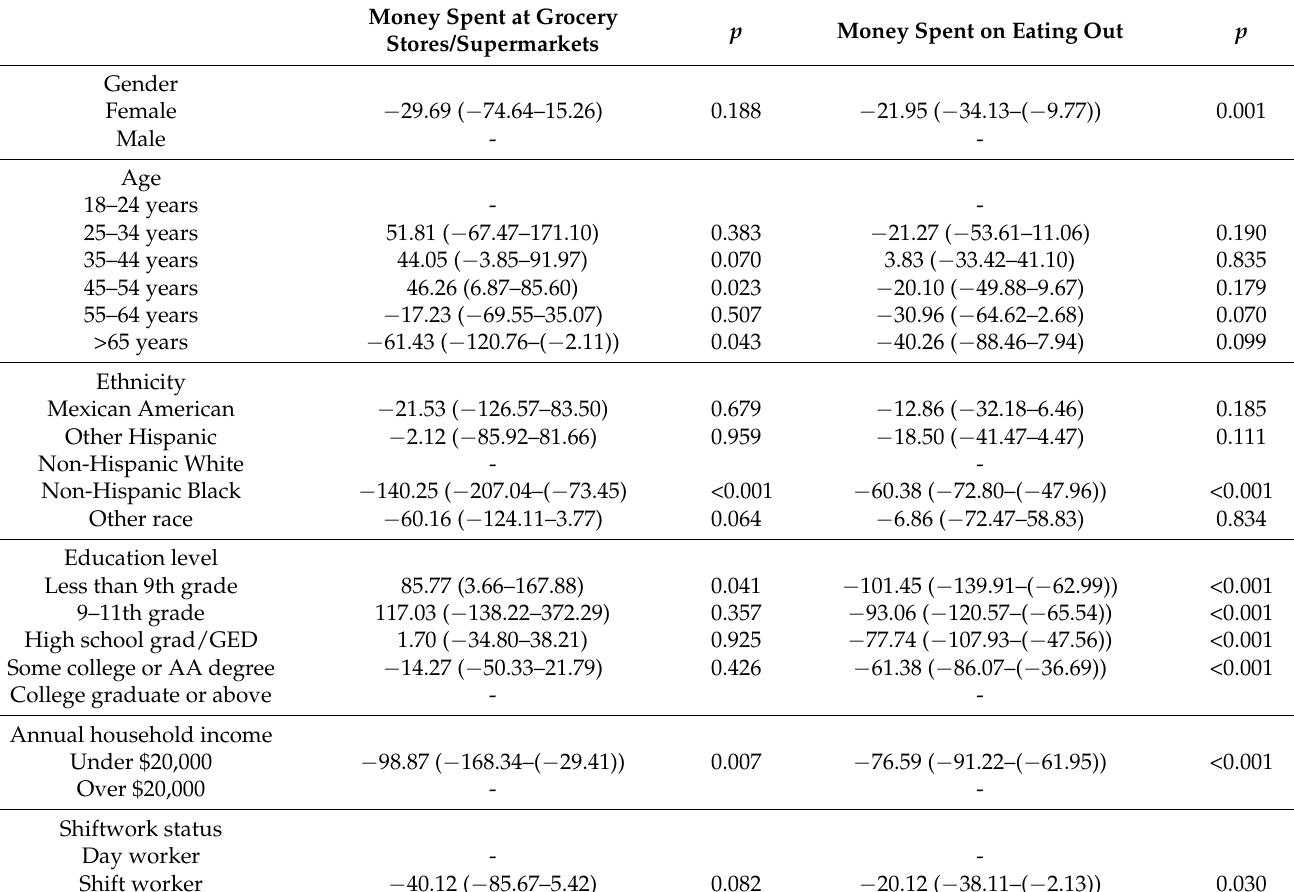
Legend: Coefficients are displayed with their 95% confidence intervals and p -value. The symbol “-” indicates the reference category. p = p